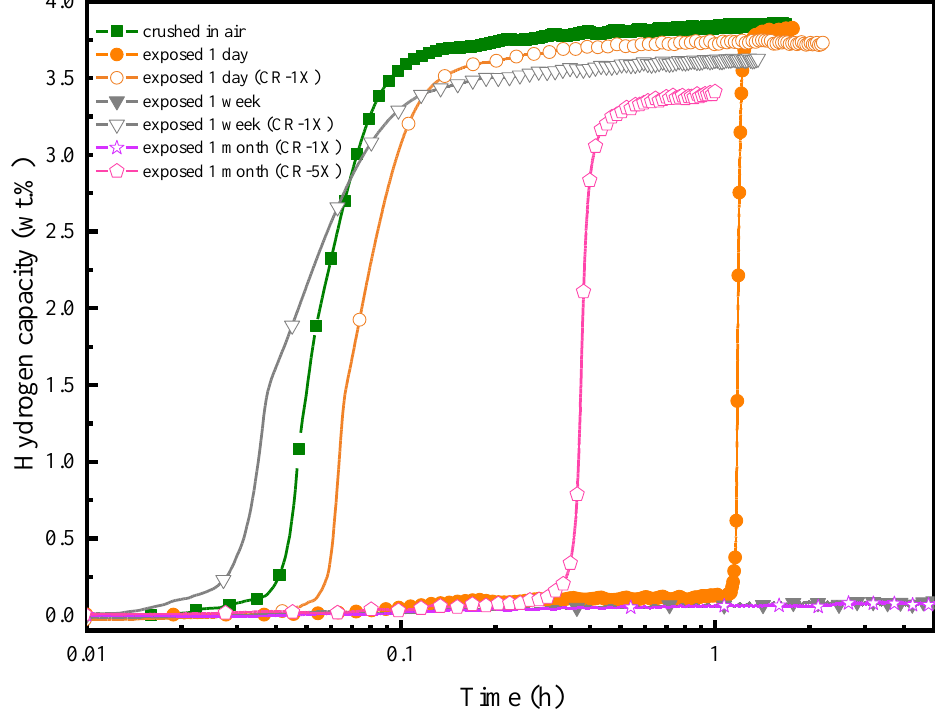
Figure 6. First hydrogenation at room temperature and 3 MPa of hydrogen of Ti 16 V 60 Cr 20 + 4 wt.% Zr alloy crushed in air and after different times of air exposure.